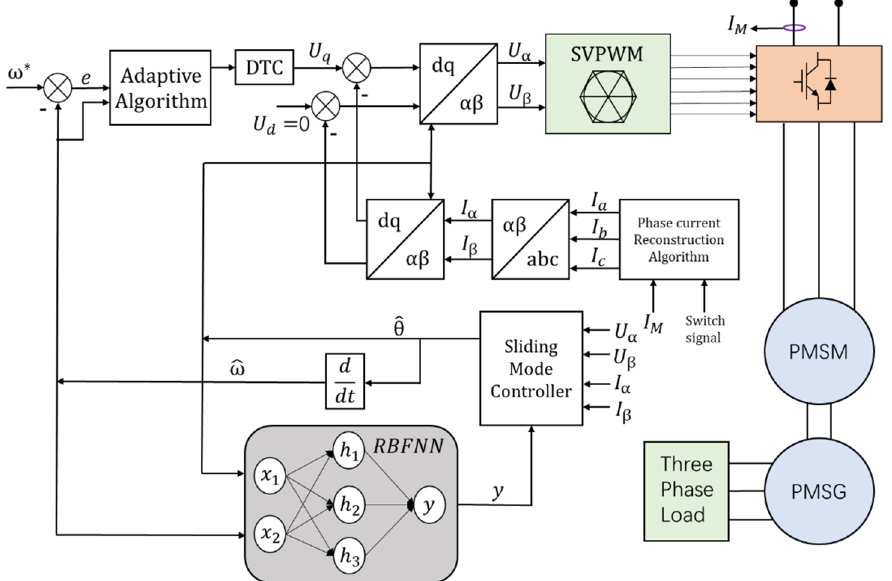
Figure 7. The proposed schematic diagram of adaptive sliding mode control using radial basis function neural network.